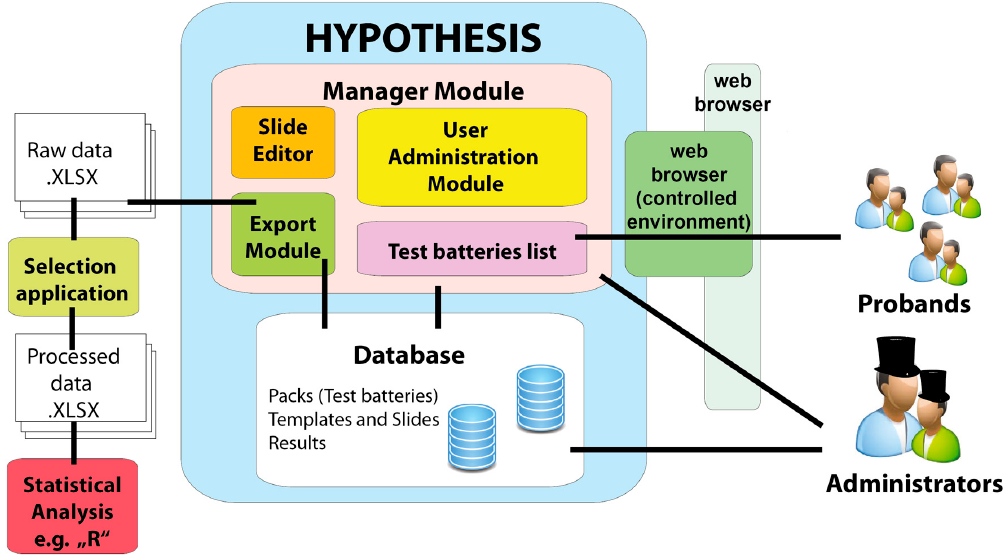
Figure 1. Basic functional components of the Hypothesis platform (modified and extended from Št ě rba et al. [42]): The first part, Database (see Section 4); the second part, Module Manager (see